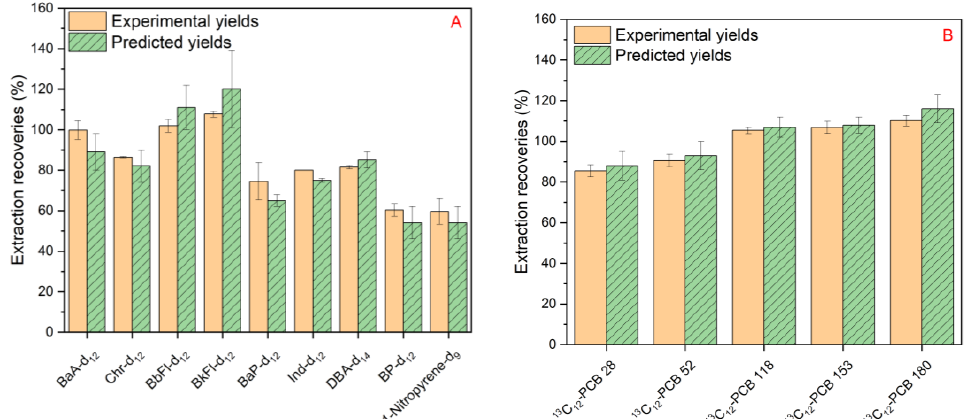
Figure 2. Predicted (green patterned) and experimental (orange) extraction yields of PAHs, nitro- PAHs ( A ) and PCBs ( B ) using the optimized extraction and clean-up conditions. Results showed that predicted extraction yields ranged from 54% to 120% recoveries (PAHs and nitro-PAH) and from 88% to 116% (PCBs), while experimental recoveries ranged from 59% to 111% (PAHs and nitro-PAH) and from 85% to 110% (PCBs). Hence, a very good agreement between modelled and experimental recoveries was obtained, with deviations lower than 10% for all the surrogates tested. Additionally, RSD% obtained for experimental replicates are below 15% for all the surrogates, thus suggesting a good repeatability.